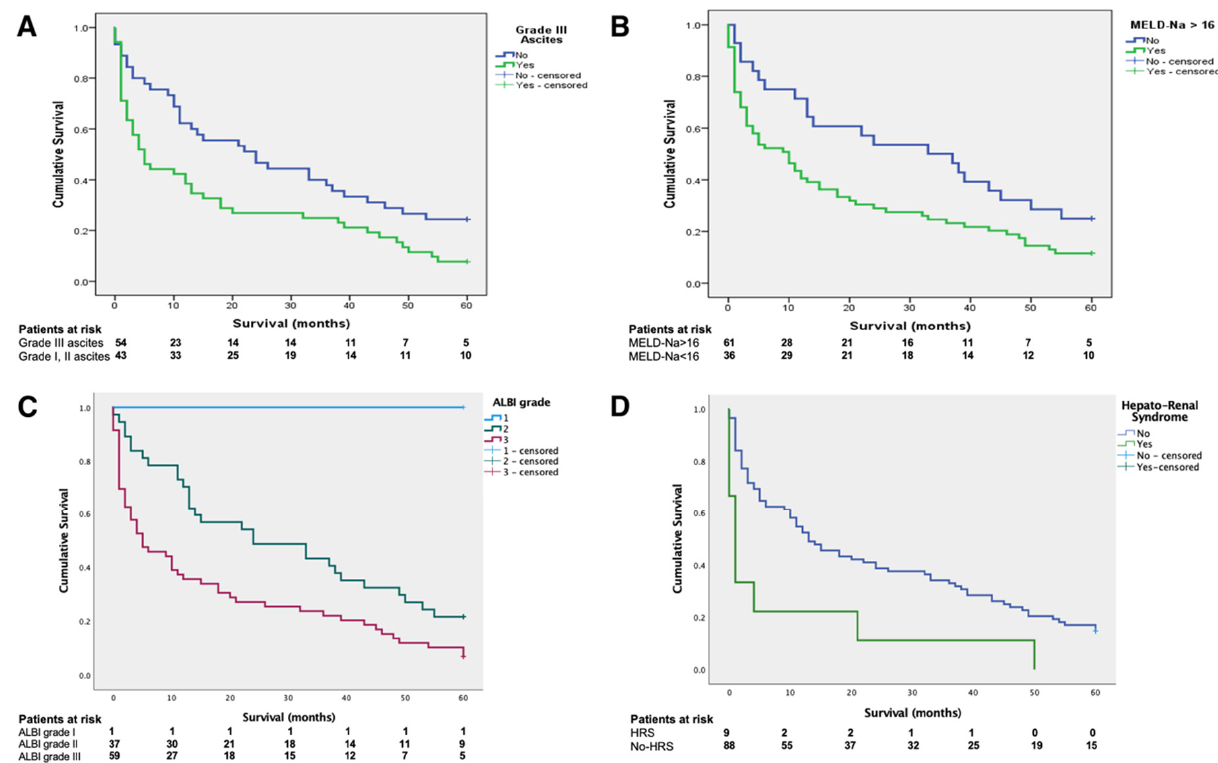
Figure 2. The subgroup survival analysis for patients with hepatic hydrothorax, based on the presence of grade III ascites ( A ), a MELD-Na score exceeding 16 ( B ), ALBI grade ( C ), and hepato-renal syndrome on the index presentation ( D